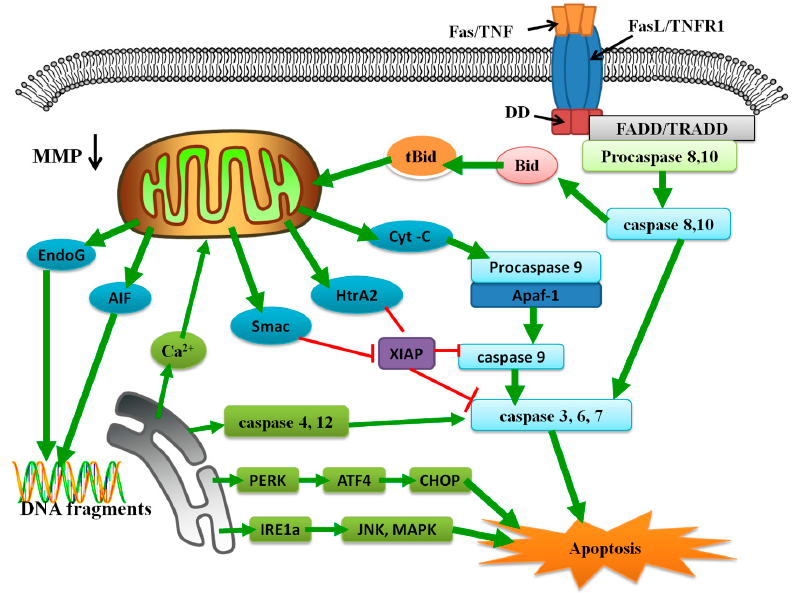
Figure 1. Summary of the extrinsic and intrinsic pathway in apoptosis. Extrinsic apoptosis: The combination of a ligand (FasL/TNFR1) and a death receptor (Fas/TNF) starts the extrinsic apoptosis